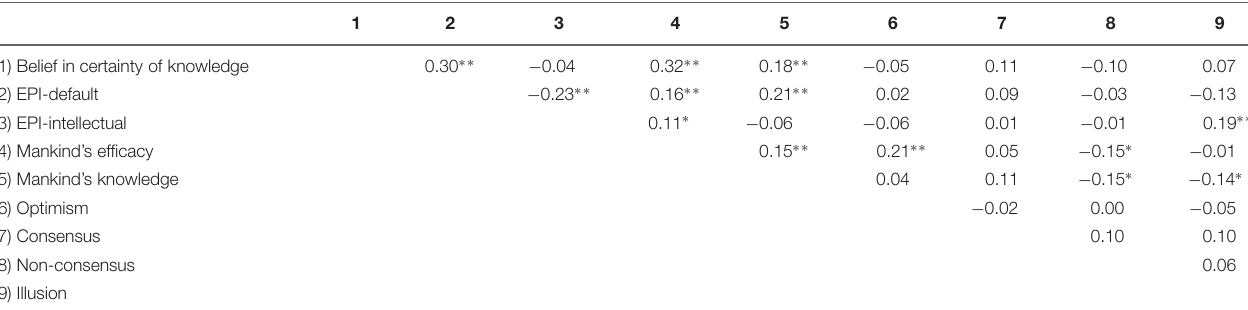
TABLE 3 | Spearman’s rho correlations between the individual difference variables and the answerability ratings of the consensus, non-consensus, and illusion questions on the future answerability scale.